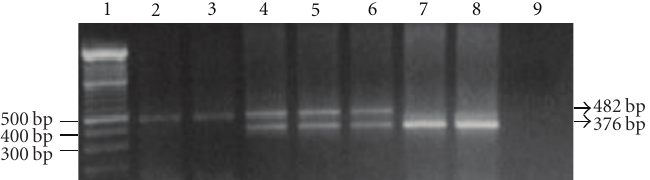
Figure 1: Detection of the Filipino β -thalassemia deletion on agarose gel after PCR. Lane 1: 100 bp molecular weight marker; lanes 2-3: normal controls with a 482-bp band; lanes 4–6: β -thalassemia carriers with the Filipino β -thalassemia deletion indicated by amplification of a 482bp normal and a 376-bp deletion specific bands; lanes 7-8: β -thalassemia major with the Filipino β -thalassemia deletion indicated by amplification of a 376-bp band; lane 9: DNA blank.